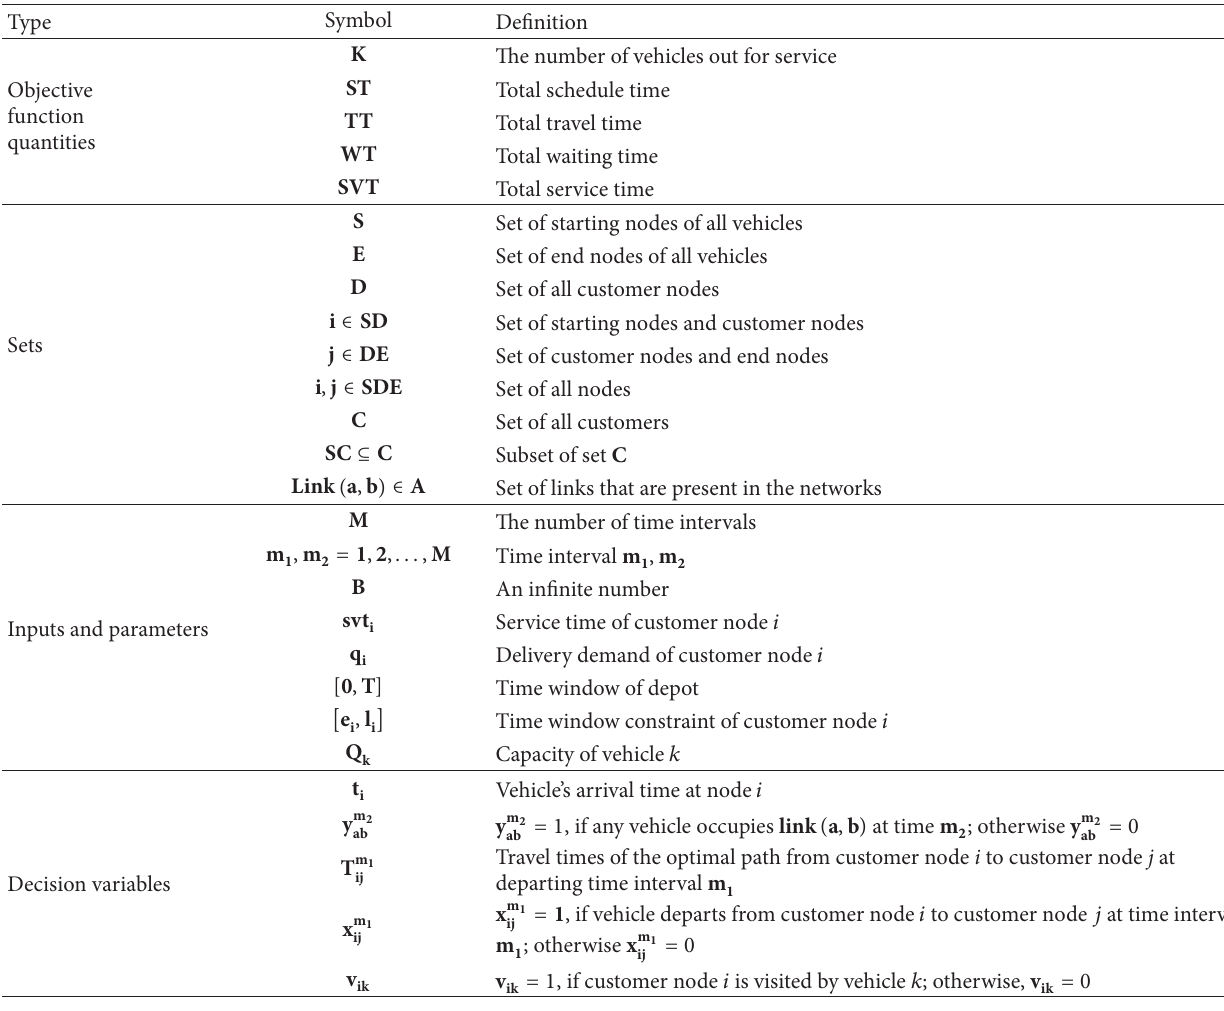
Table 1: Notations and